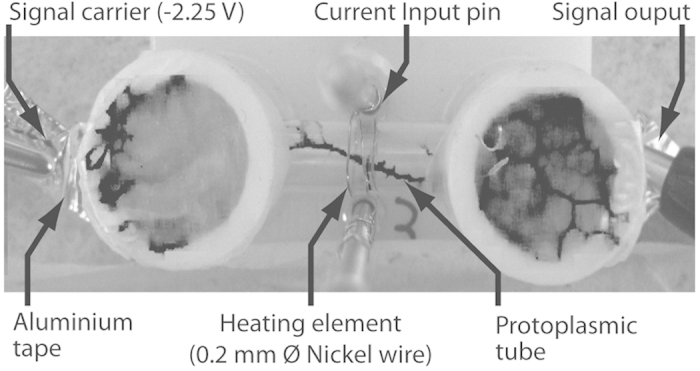
Illustration of a H-tube (Physarum heat-switch).A glass tube connects two 3D printed vessels. Each vessel hosts the slime mould. The slime mould connects spans two vessels with its protoplasmic tube.